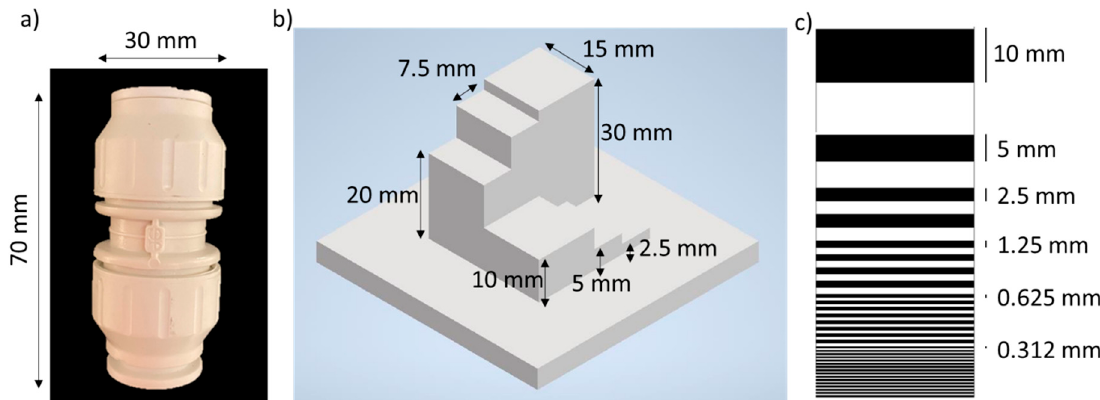
Figure 3. Targets used in the experiments. ( a ) Photograph of a plastic pipe connection. ( b ) Schematic of target used to investigate the depth resolution of the system in scattering environments. ( c ) Schematic of target used to investigate spatial resolution of the system in a number of scattering conditions.